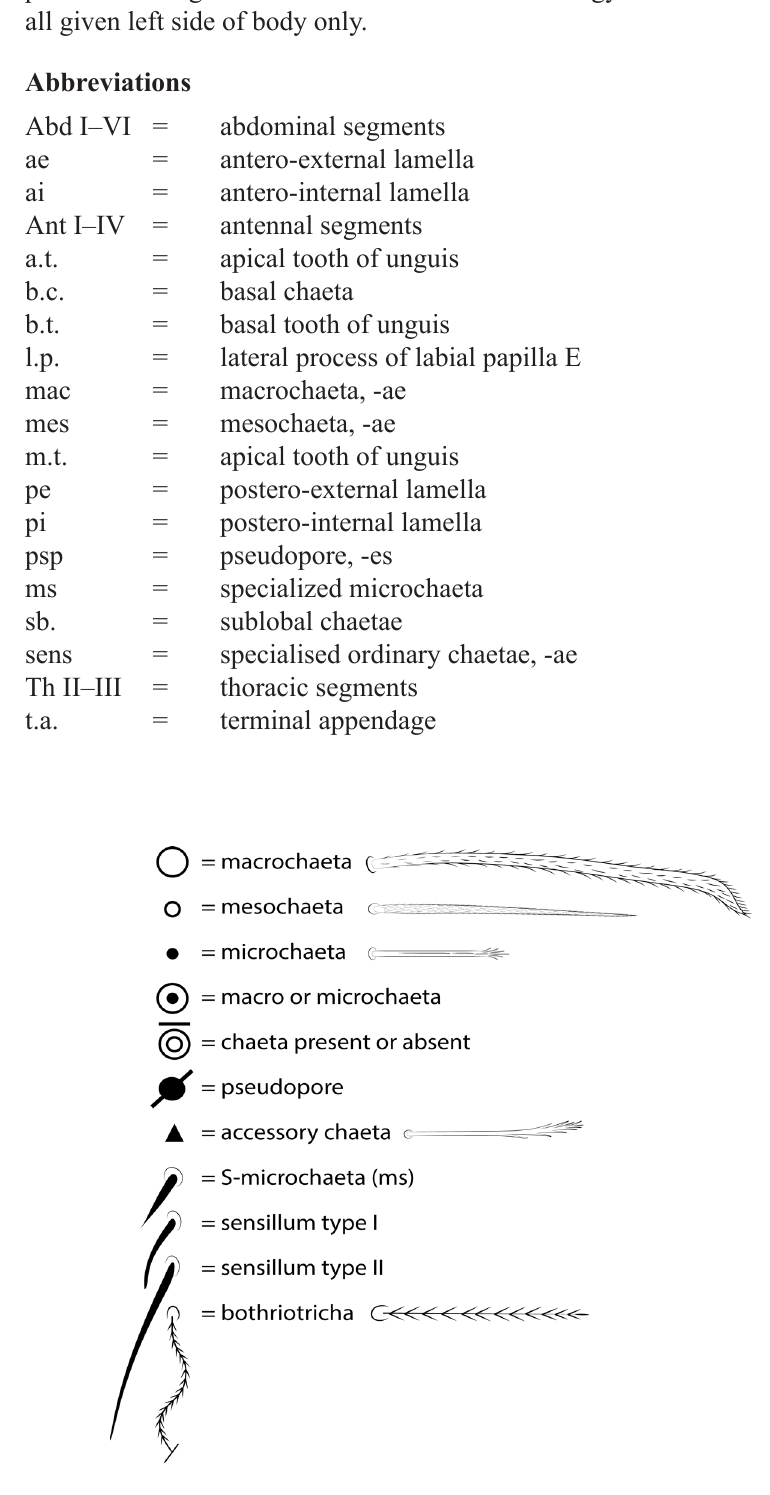
Fig. 1. Symbols used in dorsal chaetotaxy description of species of Willowsia Shoebothan,